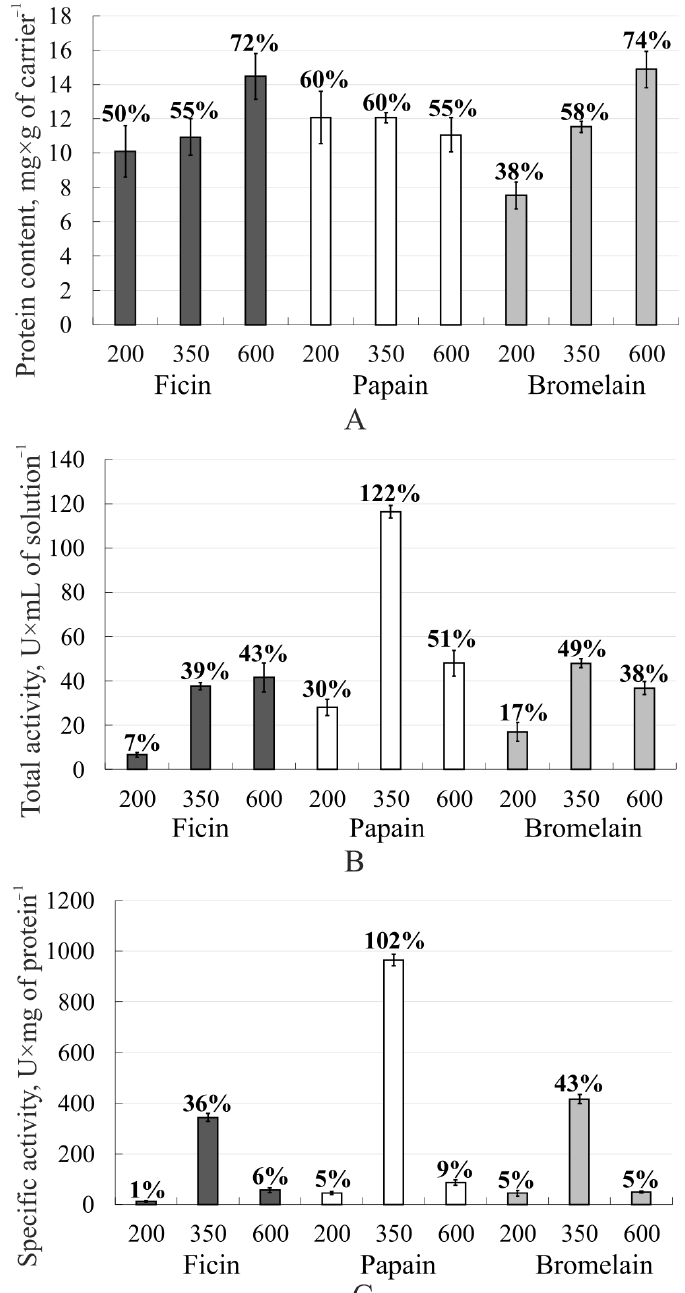
Figure 2. Immobilized ficin, papain, and bromelain characteristics: A — protein content (mg×g − 1 of carrier) in the enzyme complexes with 2-(4-acetamido-2-sulfanilamide) chitosan; B — the total activ- ity (U×mL − 1 of solution) of the enzyme complexes with 2-(4-acetamido-2-sulfanilamide) chitosan; C — the specific activity (U×mg − 1 of protein) of the enzyme complexes with 2-(4-acetamido-2-sul- fanilamide) chitosan. The efficiency of the complexation for each protease is expressed as a percent- age of the sorbed enzyme from its amount in solution ( A ), of the total activity of the immobilized enzyme compared to the soluble enzyme ( B ), and of the specific activity of the immobilized enzyme compared to the soluble enzyme ( C ) are indicated above the bars.